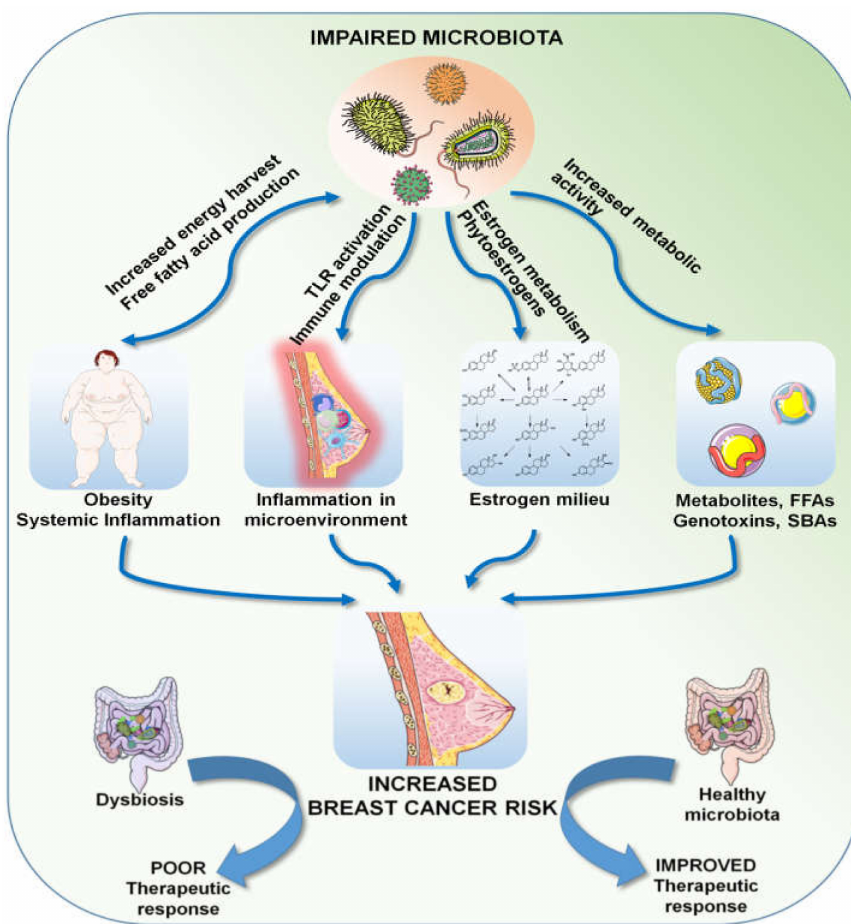
Figure 3. Multifaceted e ff ects of a dysbiotic